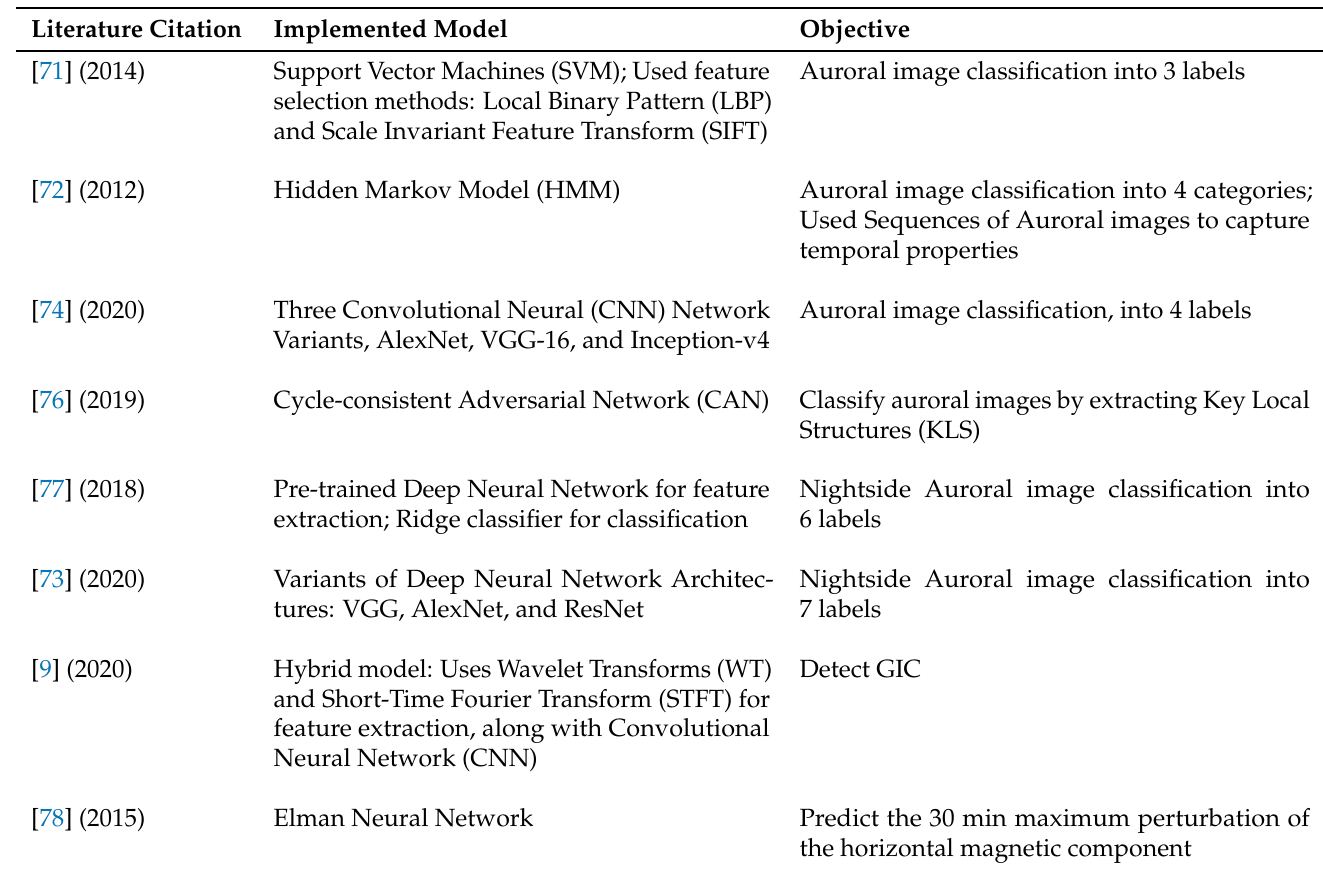
Table 1. Summary of ML models used for auroral image classification or GIC